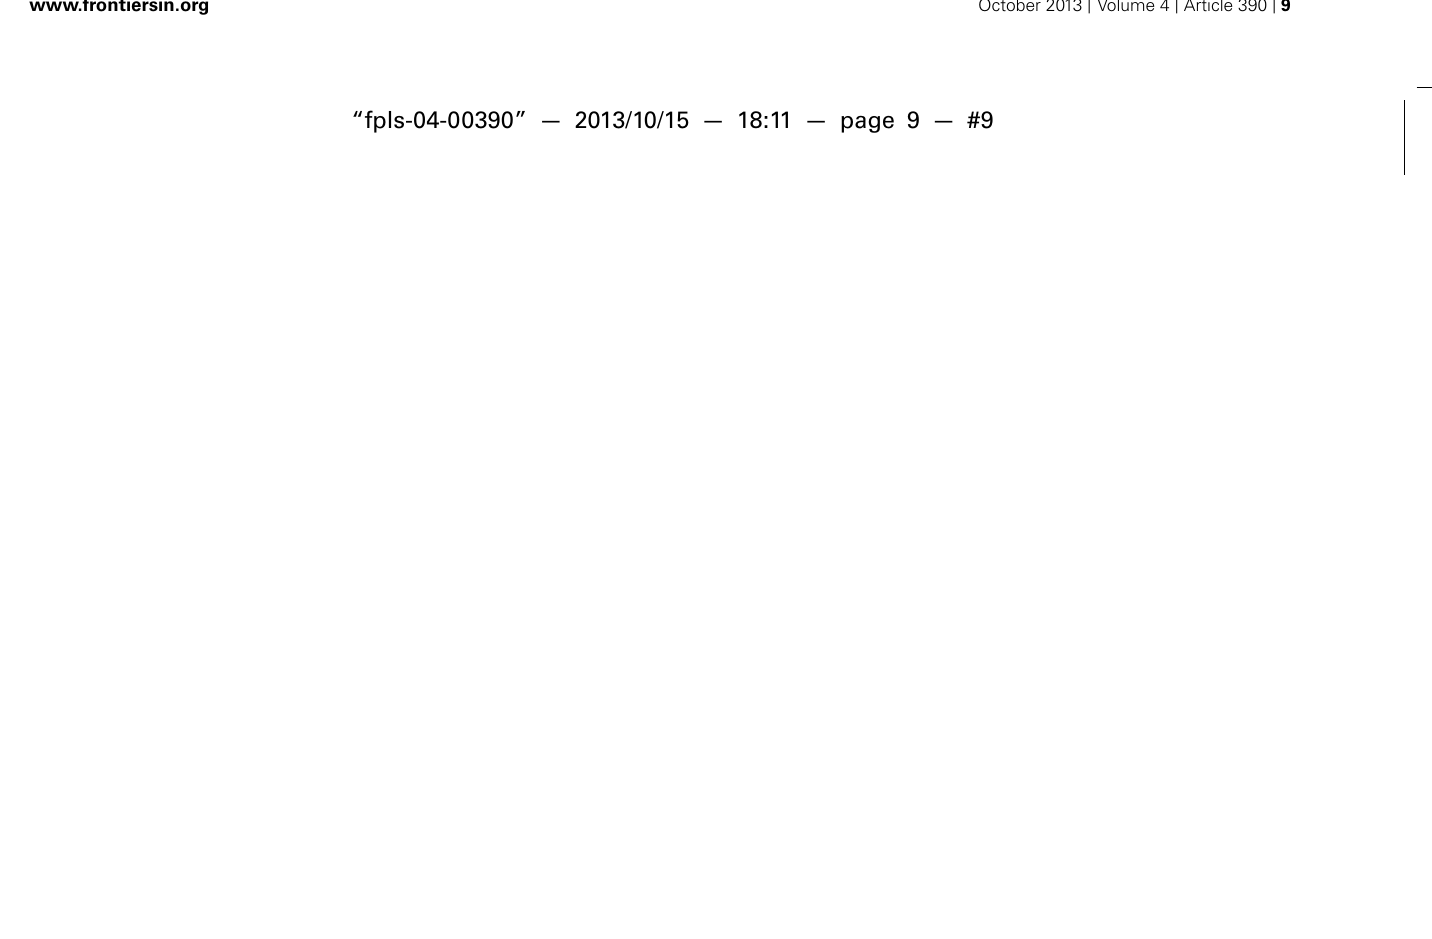
performed on two leaves (indicated by arrows in panel A ) per plant. **Value significantly different from the value measured in relative non-treated plants with p < 0.01 ( t -test). (C) Electrolyte leakage measured on tobacco leaf disks after incubation on 1 μ M MV for 14 h at 600 μ mol photons m − 2 s − 1 . Results were expressed as the percentage of total electrolytes released after treatment relative to that of disks incubated on water under the same conditions. Data are mean values ± SD from three assays.Wt, wild-type;Trx f + andTrx m + , plants overexpressingTrx f orTrx m, respectively. **Significantly different fromWt with p < 0.01 ( t